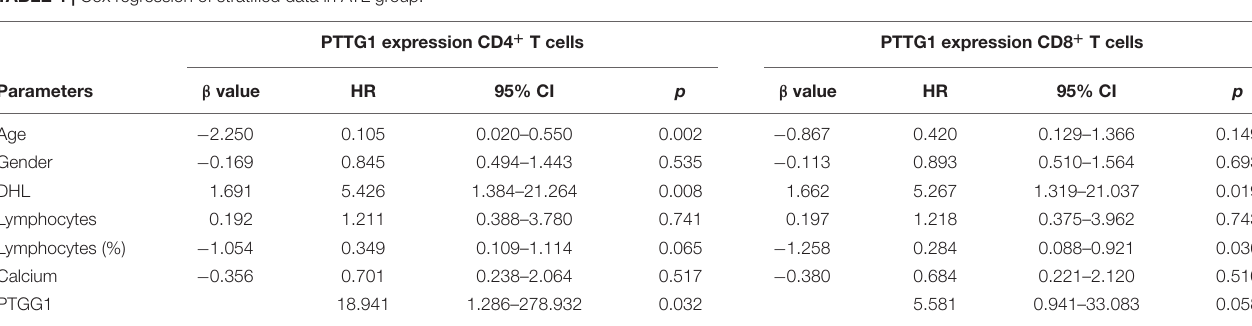
FIGURE 5 | PTTG1 gene expression in diploid and aneuploidy cases. (A) CD4 + T cells; (B) CD8 + T cells. HS, Health subjects; HTLV-1 infected, HTLV-1 asymptomatic carriers; ATL, Adult T-cell leukemia/lymphoma. * p < 0.005. TABLE 4 | Cox regression of stratified data in ATL